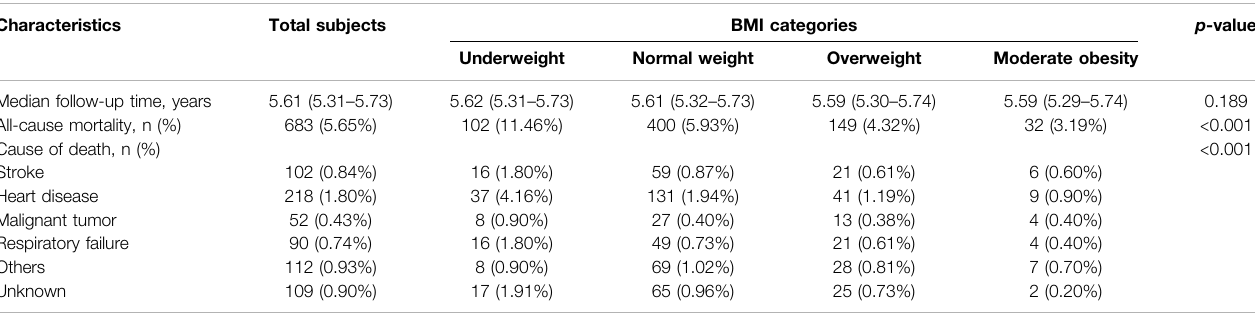
TABLE 2 | All-cause mortality of the study population by different BMI categories.